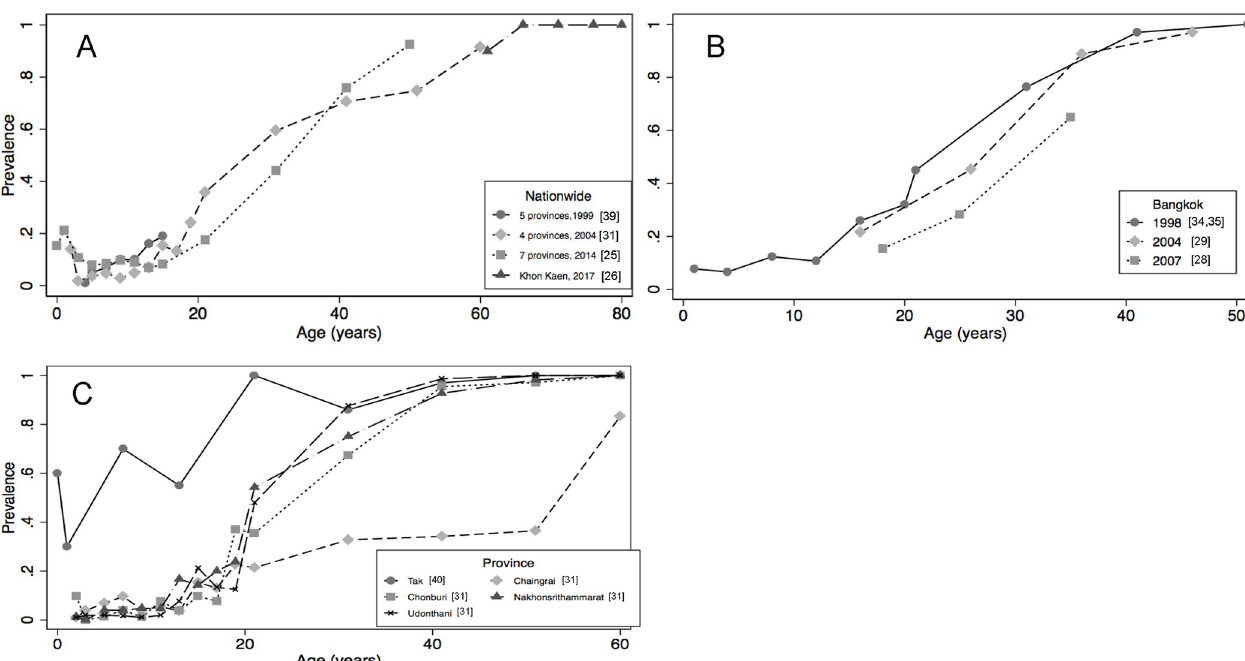
Fig 2. Age Specific HAV Seroprevalence Ɣ in Thailand in Different Regions and Years A) Surveys with National Representativeness 1999–2014 B) Surveys from Bangkok 1998–2007 C) Surveys across Different Provinces 2004 (Except Tak Province Ran in 2010). Ɣ Note: Seroprevalence measured by either detection of total HAV antibodies or specific IgG HAV in blood. Abbreviations: HAV, hepatitis A virus; IgG, immunoglobulin G.